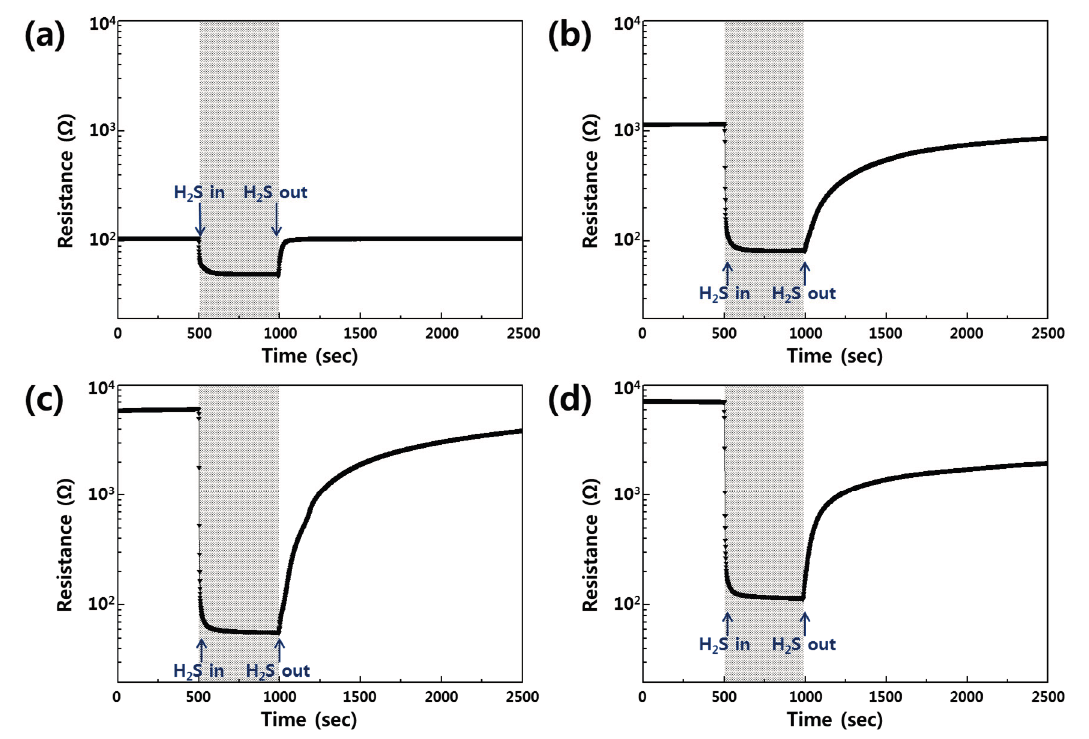
Figure 4. Gas-sensing properties of the sensors exposed to 5 ppm H 2 S at 300 °C. ( a ) SnO 2 thin film sensor; ( b ) SnO 2 nanocolumn sensor; ( c ) Au-catalyzed SnO 2 nanocolumn sensor; ( d ) Ag-catalyzed SnO 2 nanocolumn